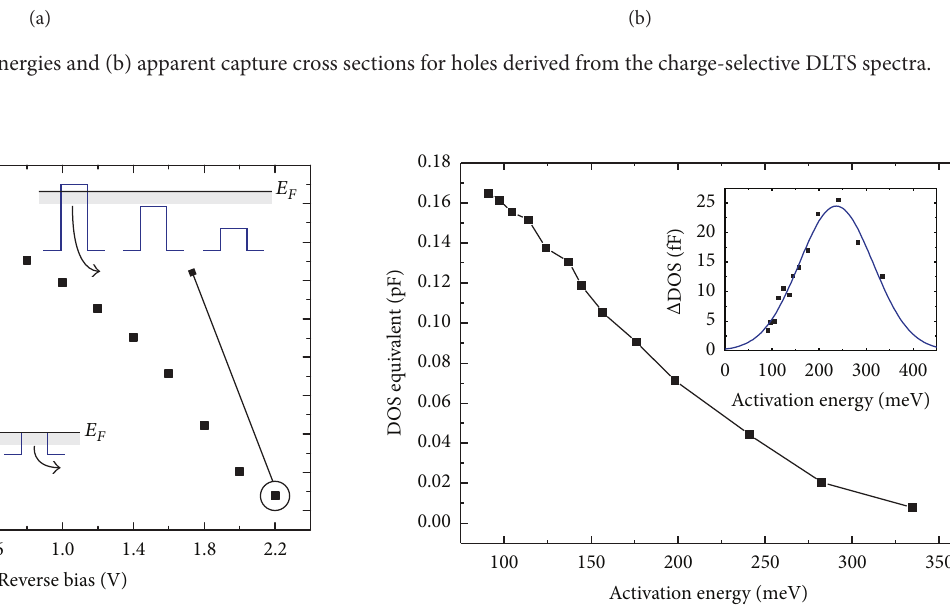
Figure 7: Density of states equivalent as a function of the activation energies determined from the charge-selective DLTS. The inset shows the individual contribution of each additional data point to the DOS equivalent; the curve resembles the density function of the confinement energies of the QDs in the